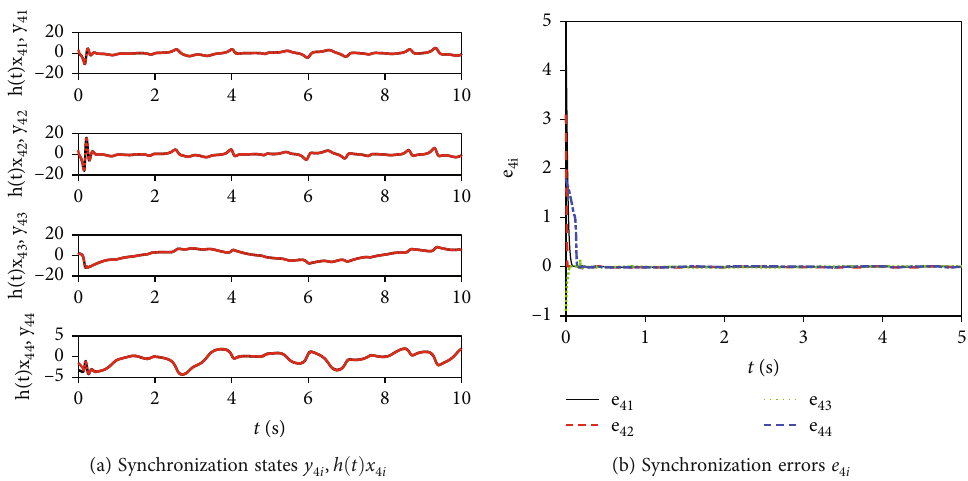
Figure 11: The time evolution of synchronization between y